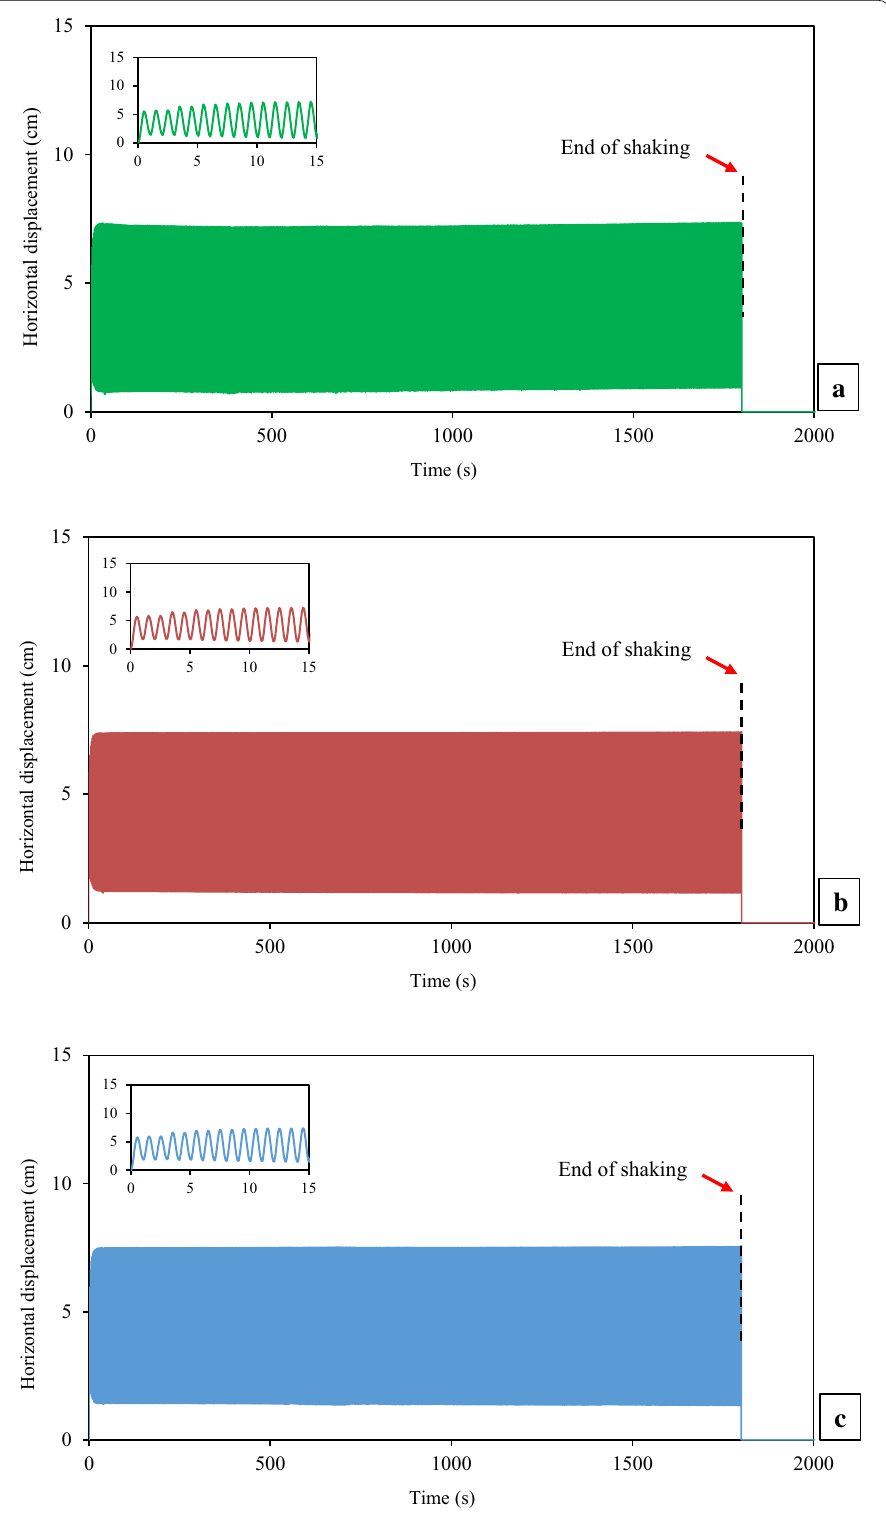
Fig. 7 Time histories of measured horizontal displacements at the intermediate depth of each layer of thickened tailings deposit during shaking: a Layer 3 (top), b Layer 2 (middle), c Layer 1